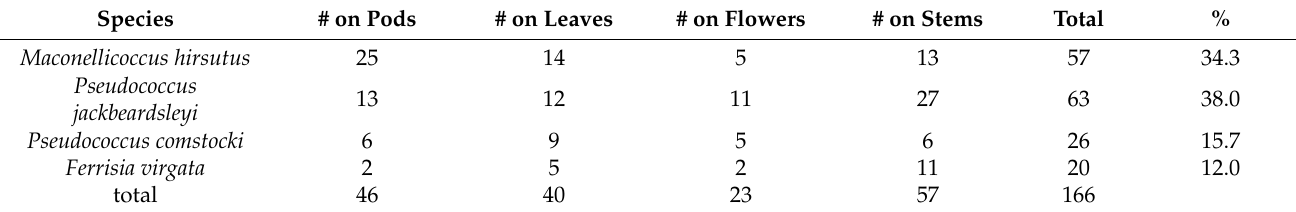
Table 4. Summary of mealybugs identified in this study and tissues from which they were